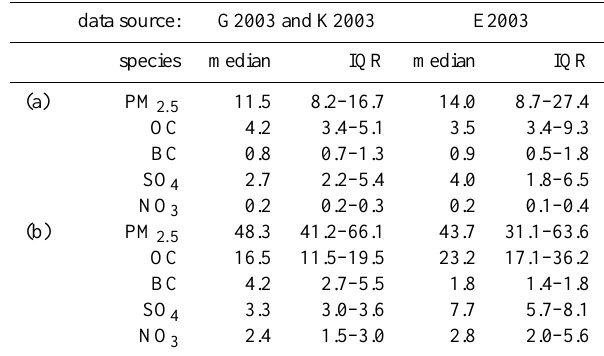
Comparison of median aerosol mass concentra- tions ( µ g/m 3 ) and interquartile range (IQR) reported by Gao et al. (2003), G2003, and Kirchstetter et al. (2003), K2003, versus those reported by Eatough et al. (2003), E2003, for samples repre- sentative of Southern Hemisphere African (a) extratropics and (b) tropics after we applied corrections based on Table